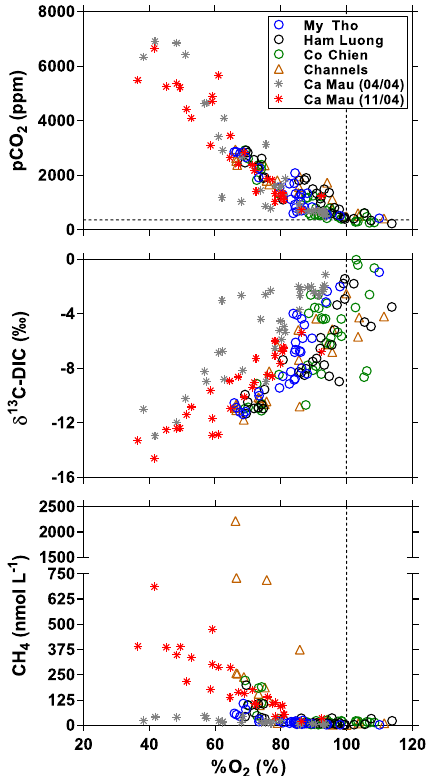
Figure 10. Distribution as a function of oxygen saturation level (%O 2 , %) of the partial pressure of CO 2 (pCO 2 , ppm), stable iso- tope composition of dissolved inorganic carbon ( δ 13 C-DIC, ‰), and dissolved CH 4 concentration (nmolL − 1 ) in the three branches of the Mekong delta (M e y Tho, Hàm Luông, and C ´ˆ o Chiên) and side channels and in the mangrove creeks of the Ca Mau province in April and October 2004. The vertical dotted line indicates O 2 satu- ration (100%); the horizontal line indicates the average atmospheric pCO 2